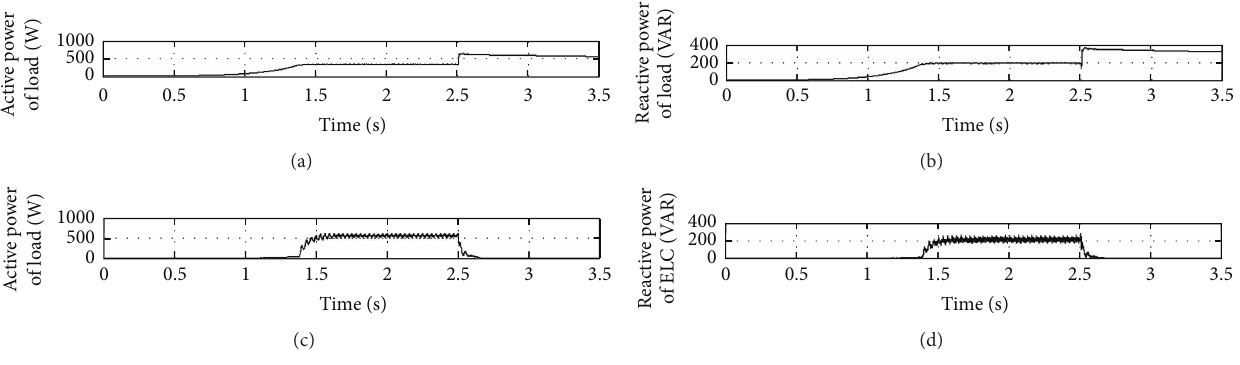
Table 3: Test results of